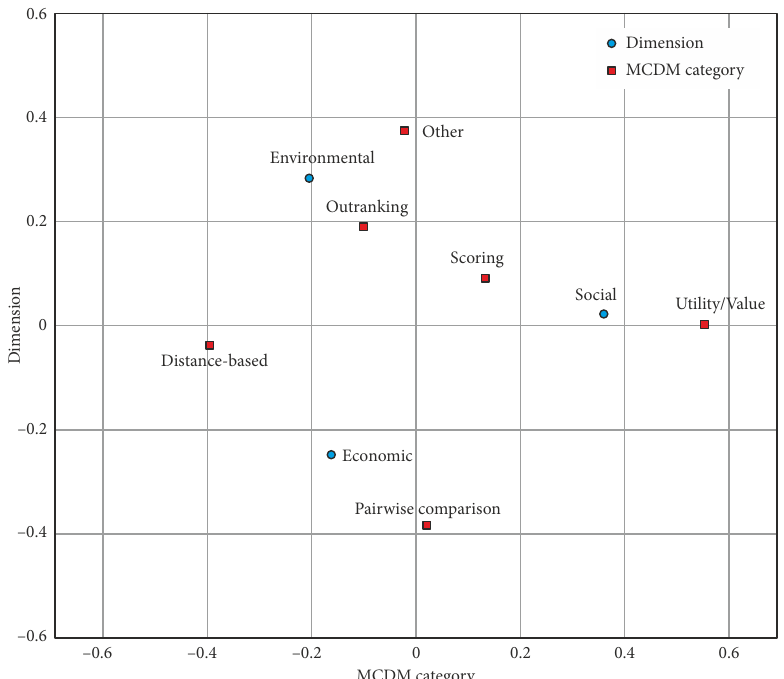
Figure 12. Simple correspondence analysis for sustainability dimension assessed and MCDM category